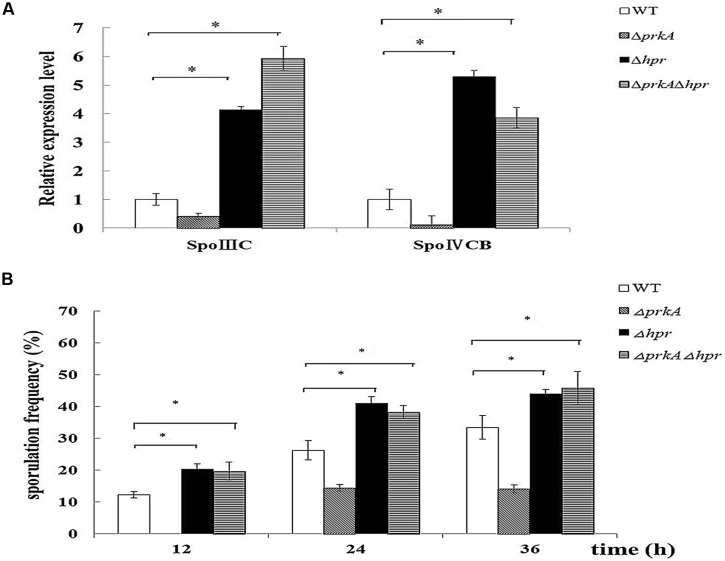
Hpr (ScoC) negatively regulates the expression of sigK in B. subtilis 168, and functions epistatic to PrkA in sporulation. (A) Hpr (ScoC) increases the expression of the transcriptional factor σK. Real-time PCR was employed to detect the relative expression levels of the transcriptional factor σK, which included spoIIIC and spoIVCB. (B) Effect of the gene hpr on sporulation. Sporulation frequencies in WT strain B. subtilis 168, ΔprkA mutant, Δhpr mutant, and ΔprkAΔhpr mutant were determined at 12, 24, 36 h, respectively. ∗P < 0.01.